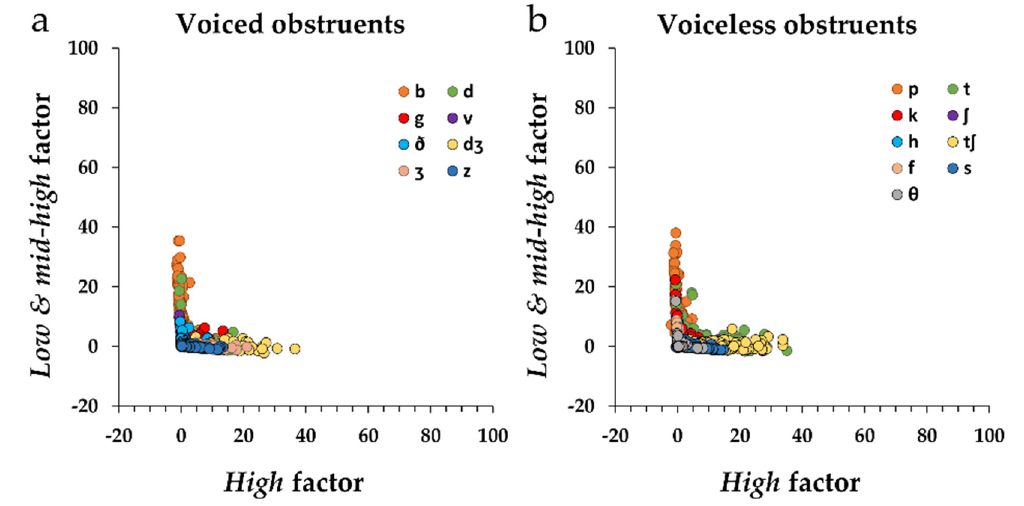
Figure 6. The L-shaped distributions of voiced obstruents ( a ) and voiceless obstruents ( b ) in the two-dimensional space of the “low & mid-high factor” and the “high factor”. Factor scores of the three extracted spectral factors were obtained by origin-shifted factor analysis with cepstral liftering (cf. Figure 2) and the English speech samples were from three native speakers.